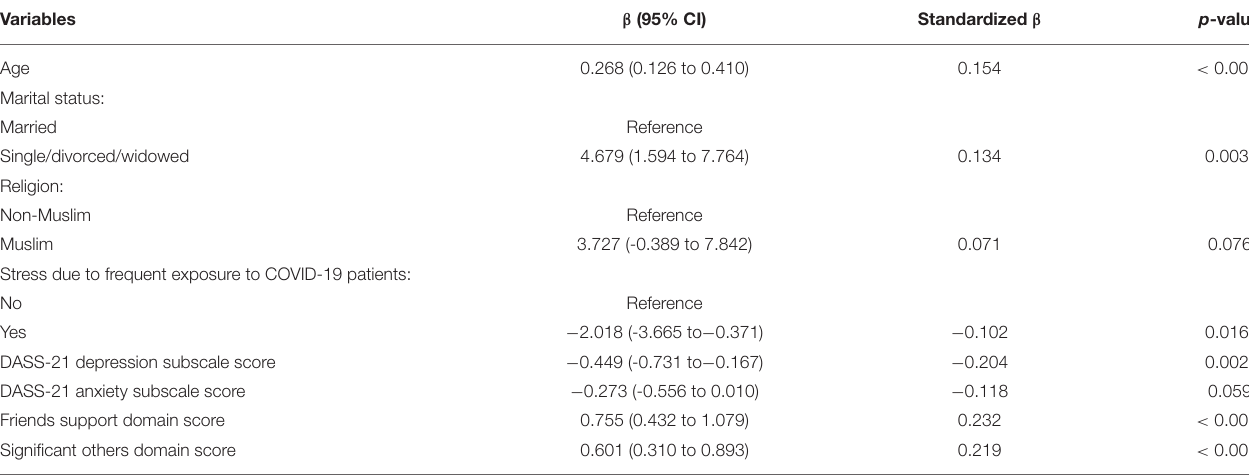
TABLE 6 | Multiple linear regression analysis with backward selection method between demographic and personal characteristics, COVID-19 related factors, psychological characteristics, perceived social support, and environmental QoL among the